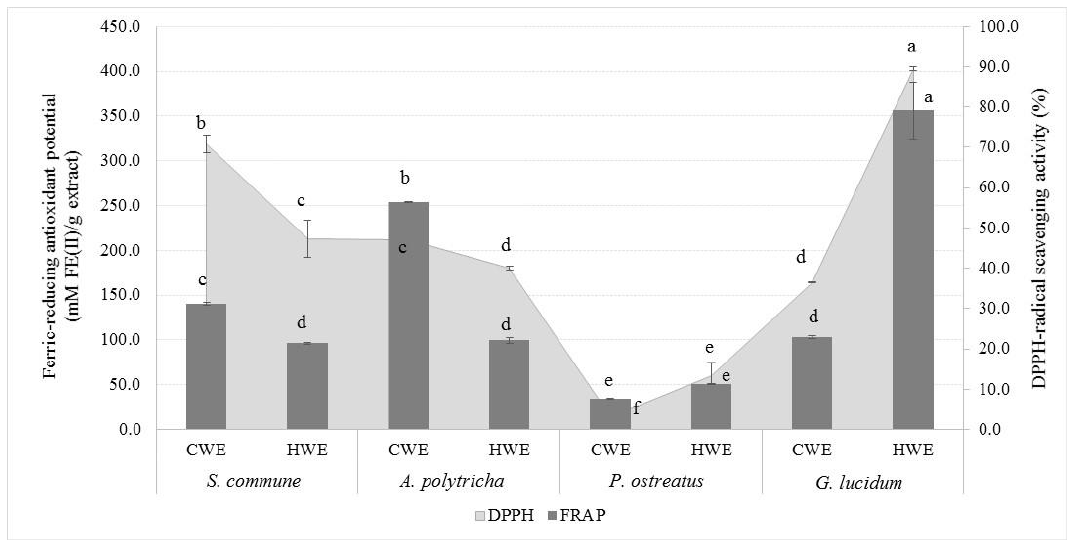
Figure 2. DPPH radical scavenging activity and ferric-reducing antioxidant potential (FRAP) of extracts from multiple types of mushroom. The values with the same letter in each category are not significantly different at p > 0.05 by one-way ANOVA.